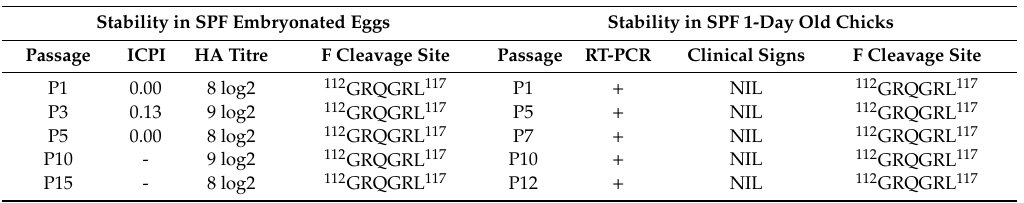
Table 3. Stability of monobasic fusion protein cleavage site and lentogenic phenotype of NDV mIBS025 in SPF eggs and